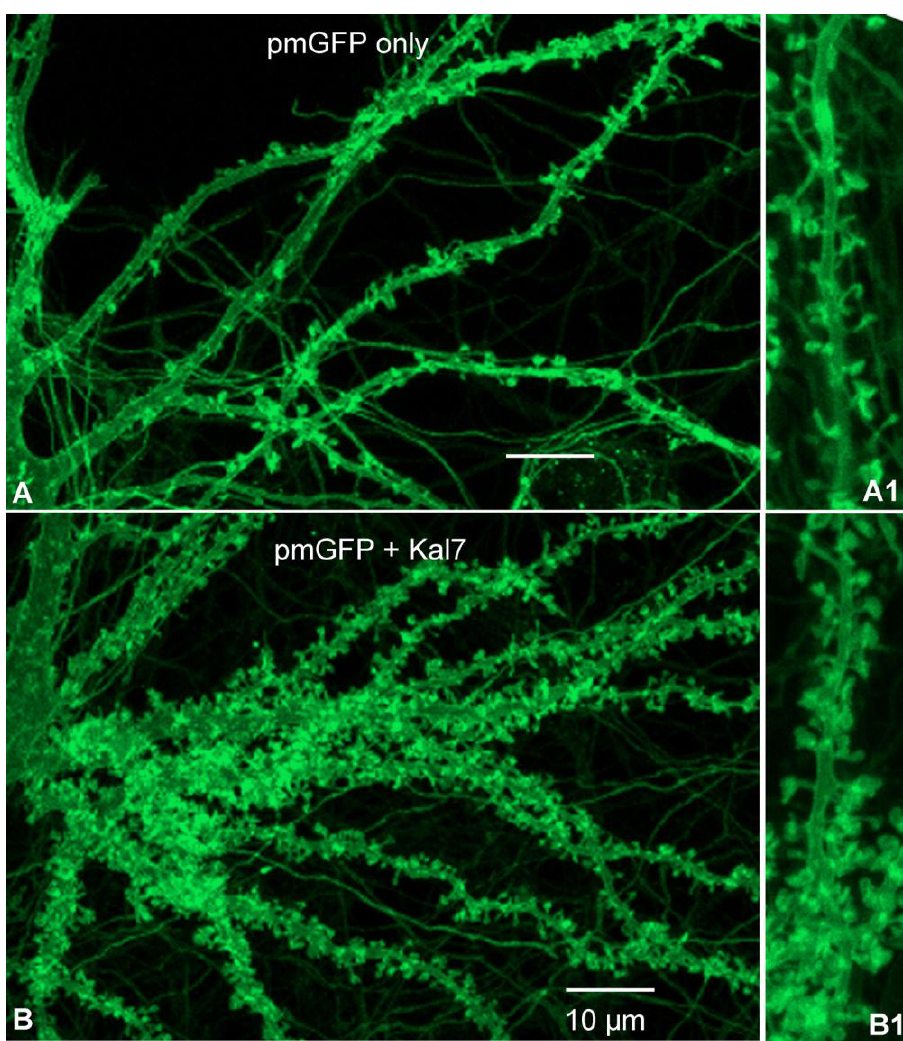
FIGURE 3. Kal7 increases spine density in cultured hippocampal neurons when overexpressed. Hippocampal neurons prepared from postnatal day 1 rat pups were transfected with a vector encoding a membrane-tethered version of GFP (pmGFP) alone (A, A1), or vectors encoding both pmGFP and myc-Kal7 in a 1:2 ratio (B, B1) as described[45]. Z-step (0.2 μm) images of live cells were taken at DIV16 with a Zeiss LSM 510 confocal microscope. Expression of Kal7 was verified by Myc staining as described (not shown)[45]. A1 and B1 are high-power images from A and B, respectively. Neuronal preparation, transfection, and immunostaining were performed as